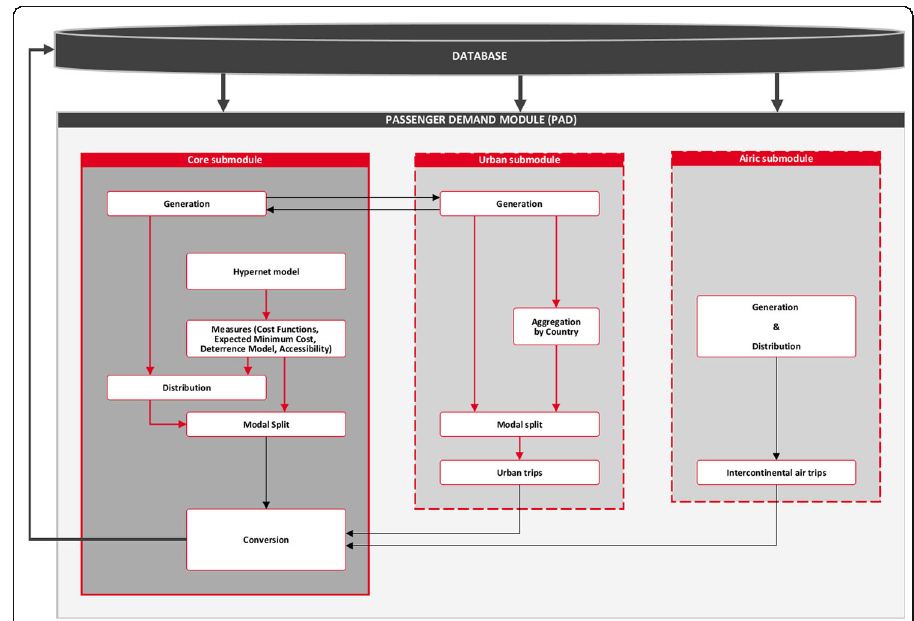
Fig. 5 Structure of the Passenger Demand